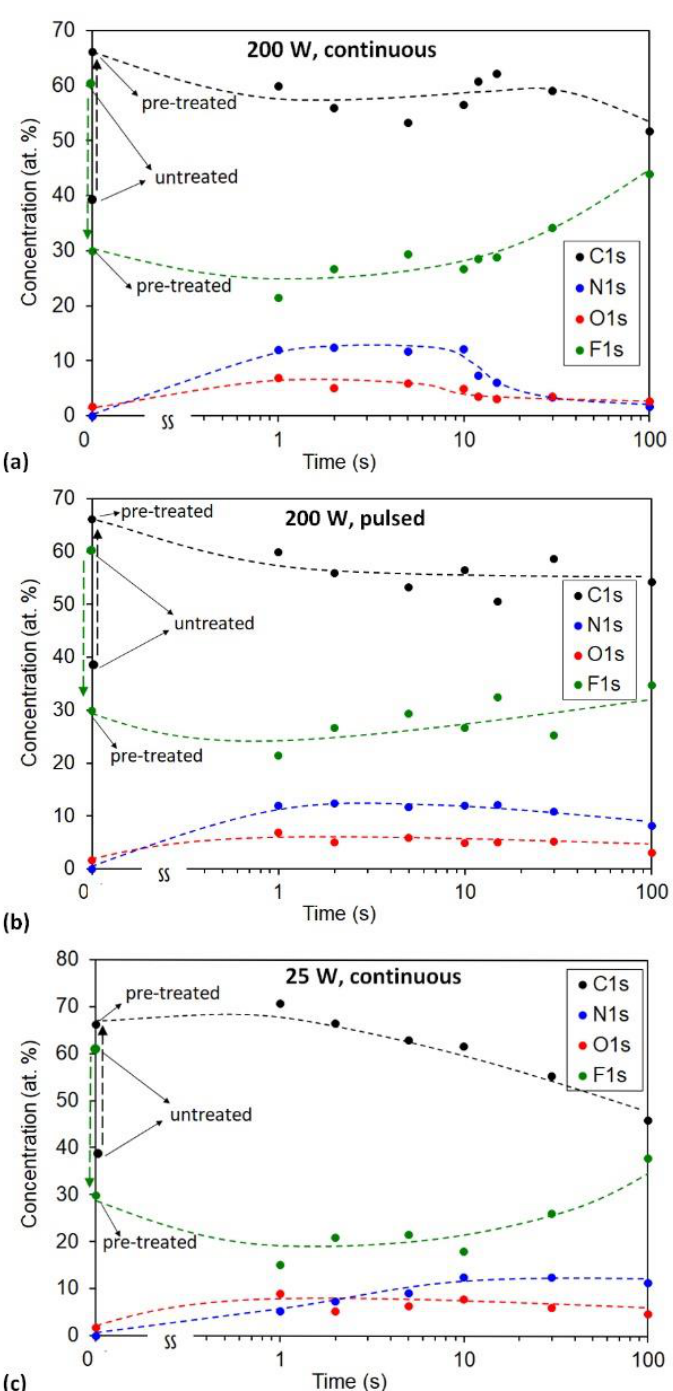
Figure 4. The XPS surface composition versus treatment time in ammonia plasma: ( a ) 200 W, continuous treatment ( b ) 200 W, pulsed treatment and ( c ) 25 W, continuous treatment. All samples were pretreated with hydrogen plasma at 35 Pa, 600 W for 1 s.